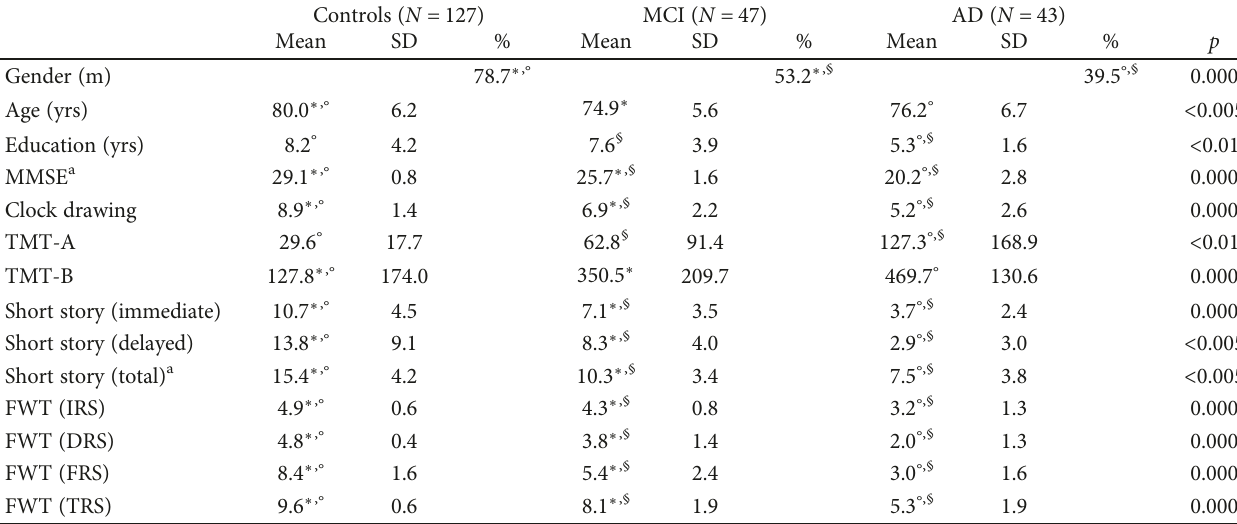
Table 1: Demographic data and neuropsychological assessment of a sample of 217 patients consecutively recruited in an Alzheimer evaluation unit and of three subgroups with control subjects, mild cognitive impairment due to Alzheimer ’ s disease (MCI), and dementia due to Alzheimer ’ s disease